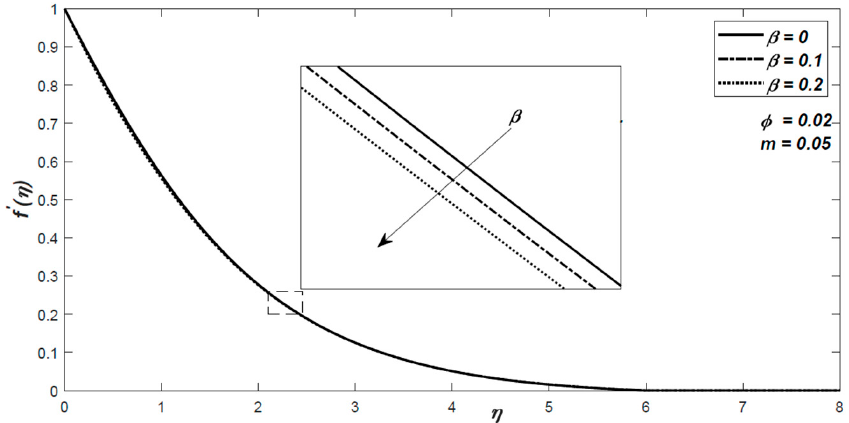
Figure 4. The variation of the nondimensional velocity for different values of the ferromagnetic parameter β